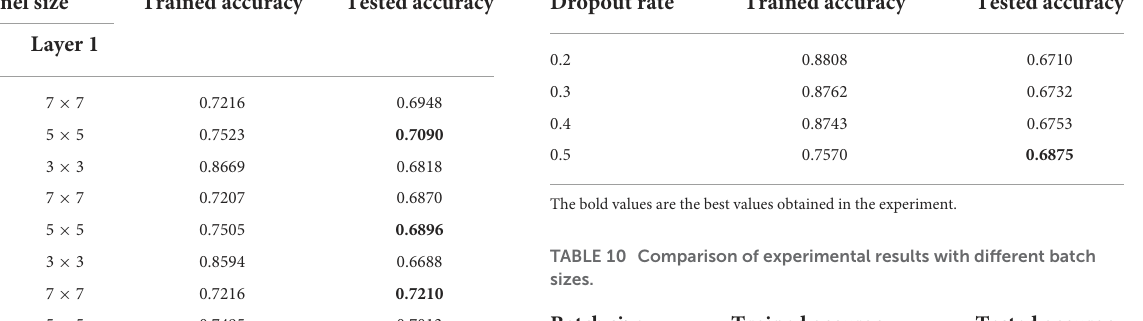
TABLE 7 Comparison of experimental results with different kernel sizes. Kernel size